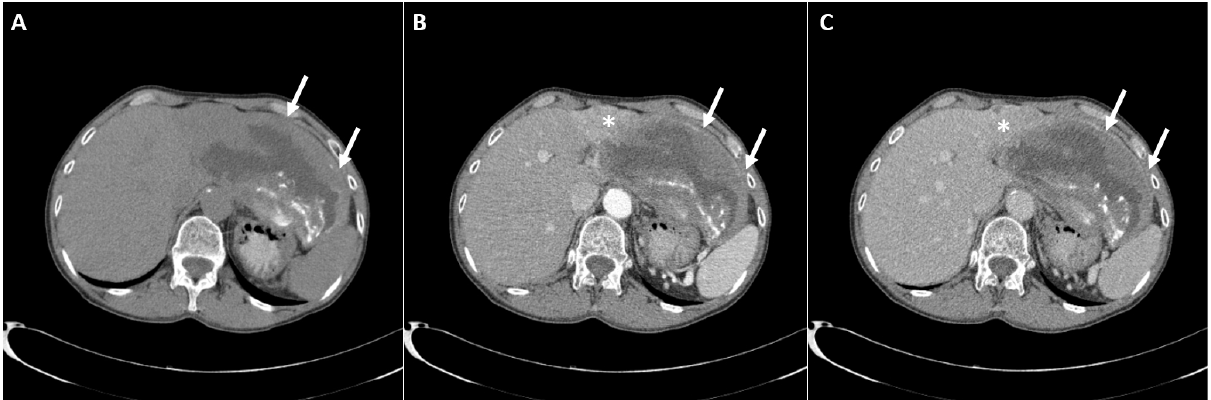
Figure 1. Computed tomography examination native scan ( A ) shows a large, heterogeneous, predominantly cystic lesion with irregular, eccentric, coarse calcifications inside necrotic debris (arrows). After the intravenous contrast administration arterial phase ( B ) shows an ill-defined hyper-vascularized solid tumor (asterisk) in liver segment IV adjacent to the cystic lesion (arrows). In the portal-venous phase ( C ) a discrete washout of the solid tumor is seen. Note the absent opacification of the internal cystic component, with only a slight enhancement of the cystic wall.